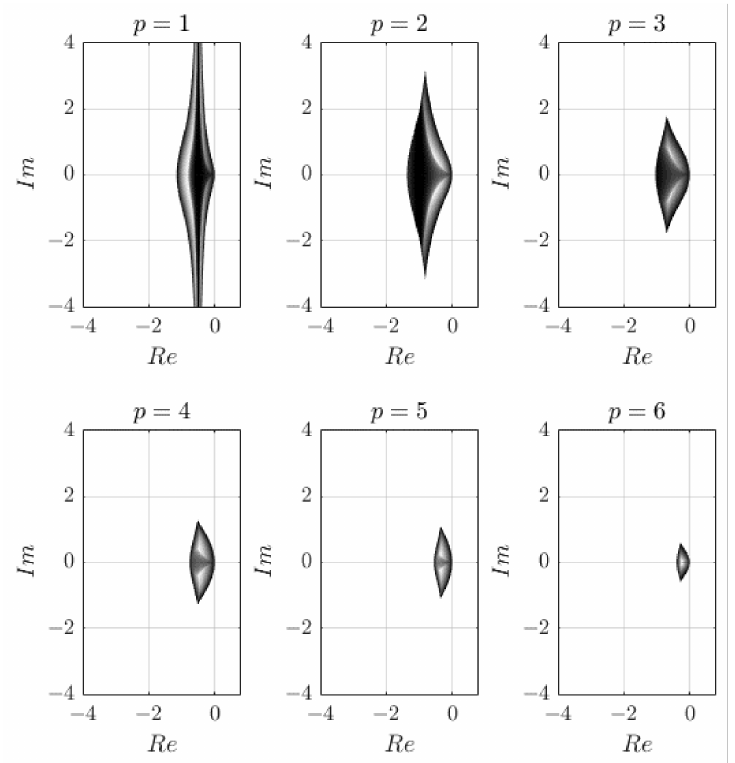
Figure 3. Stability regions of the semi-implicit Adams–Bashforth–Moulton methods with k =